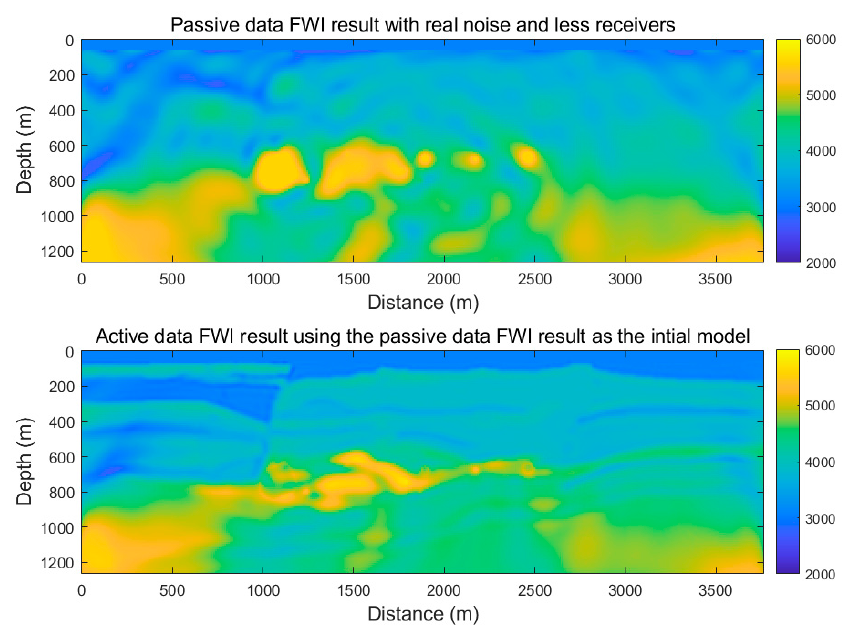
Figure 13. The source independent multisource FWI results of the real noise datasets with less passive shots and less receivers. The upper figure shows the FWI result only using the passive dataset. The lower figure shows the FWI result when using both active and passive